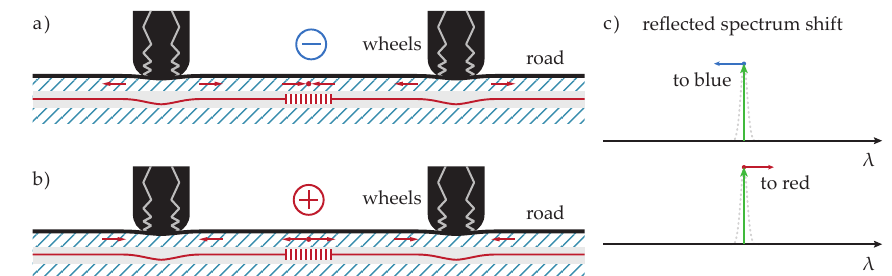
Figure 3. Illustration of some scenarios of wheel pressure to horizontally oriented FGB sensors ( a ) when the wheel’s pressure in the horizontal line is negative (compressive stress) or ( b ) positive (tensile stress), ( c ) and the appropriate reflected light spectrum change in